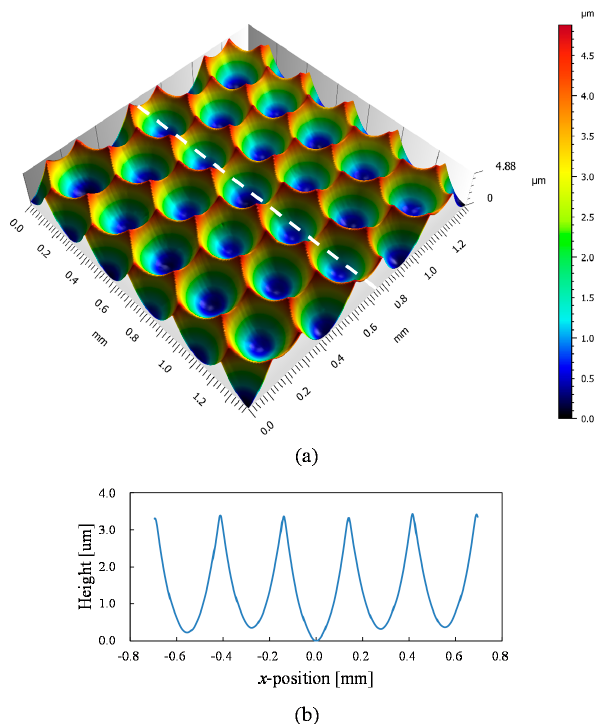
Figure 18. Lens shape measurement results: ( a ) three-dimensional topography of a hexagonal microlens array; and ( b ) cross-sectional profile measured along the white dashed line shown in ( a ).